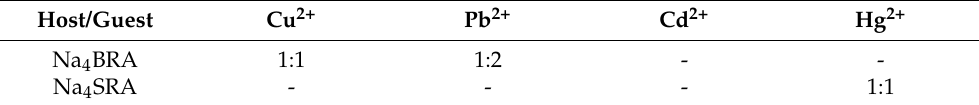
Table 3. Stoichiometry of the complexes formed with the hosts Na 4 BRA and Na 4